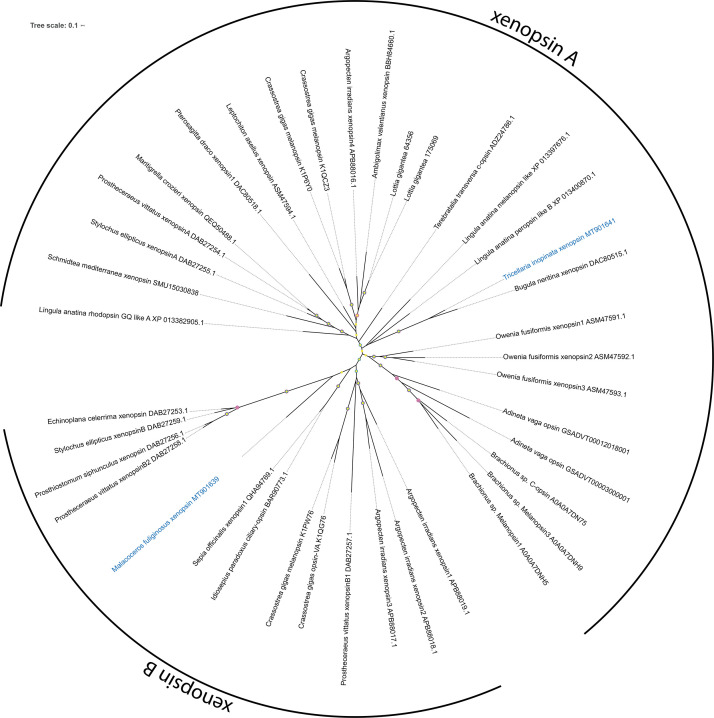
Unrooted xenopsin tree.Maximum Likelihood analysis (IQ-TREE, LG+F+I+G4). Labeled nodes have support values of approximate Bayes test ≥0.98 (yellow dot), SH-like approximate likelihood ratio test ≥90 (blue dot), and ultrafast bootstrap ≥90 (purple dot). The sequences investigated in this study are highlighted in blue.